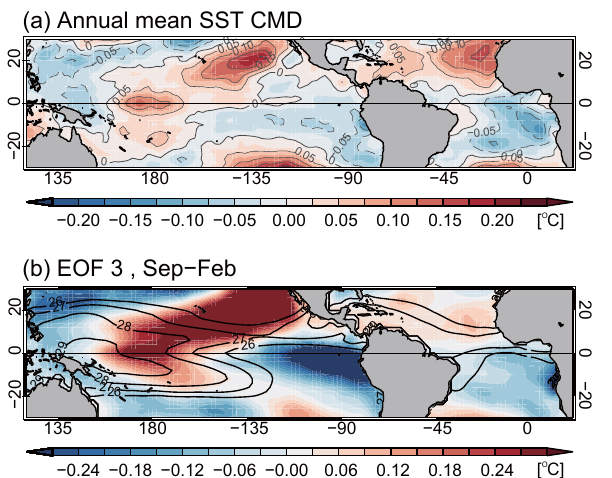
Figure 10. (a) Same as Fig. 1a, except for the tropical Pacific and Atlantic sectors only (30 ◦ S–30 ◦ N, 120–20 ◦ E). (b) SST spatial structure of the third EOF in September–February for the period 1880–2010 (colour shading). Contours indicate climatological SST.